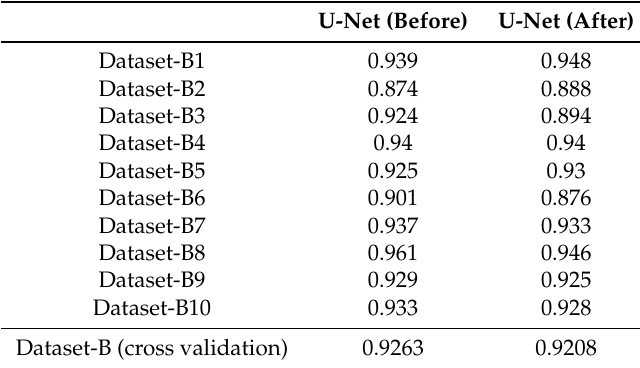
Table 13. IoU measured on Dataset-B before and after applying the DSC on the U-Net network. U-Net (Before)